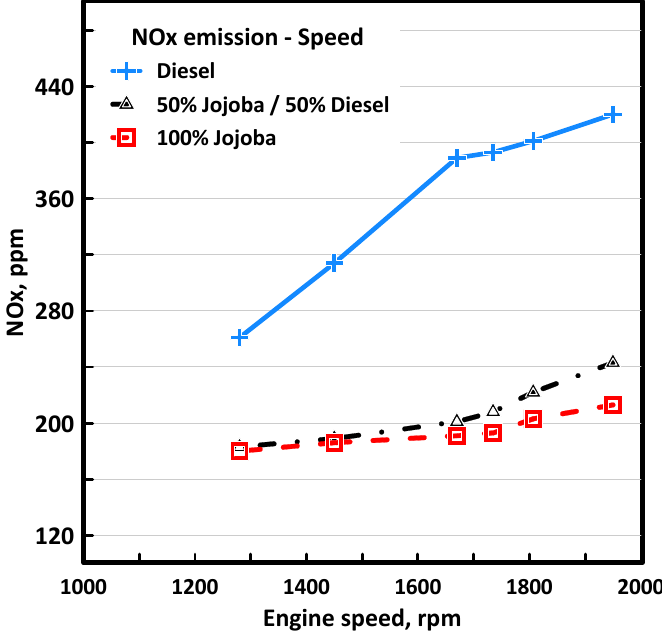
Figure 9. NOx emission of pure diesel fuel, raw Jojoba oil, and 50/50 blend.